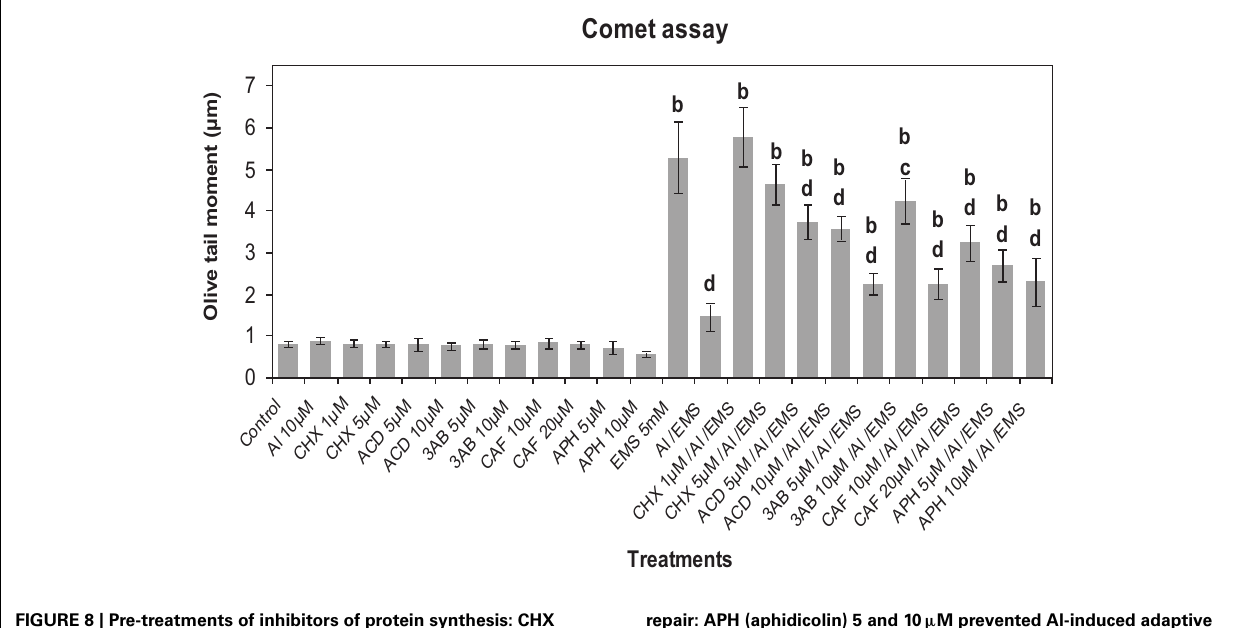
repair: APH (aphidicolin) 5 and 10 µ M prevented Al-induced adaptive response to DNA damage induced by EMS 5mM in root meristems of A. cepa . Increase significant compared to control (0) at p ≤ 0 . 01 (b); decrease significant compared to EMS-challenge at p ≤ 0 . 05 (c) or 0.1 (d).